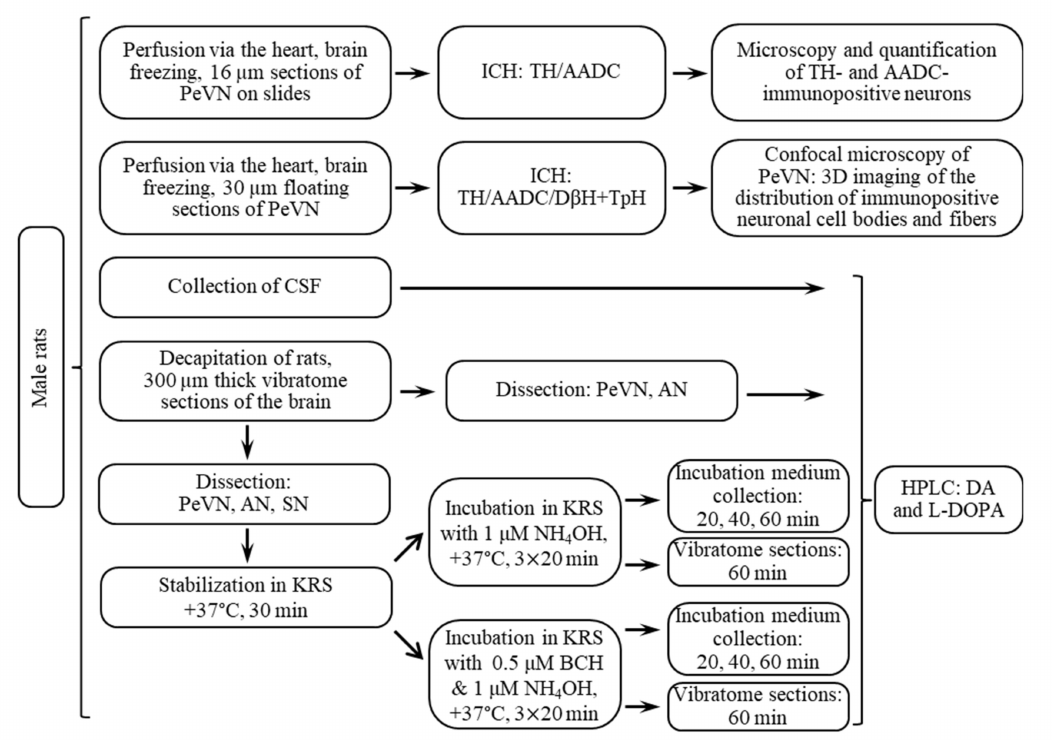
Figure 10. Scheme of experiments carried out on male Wistar rats at the age of 30 days. AADC, aromatic L-amino acid decarboxylase; AN, arcuate nucleus; BCH, 2-amino-2-norbornanecarboxylic acid; DA, dopamine; D β H, dopamine β hydroxylase; L-DOPA, L-3,4-dihydroxyphenylalanine; HPLC, high-performance liquid chromatography; ICH, immunocytochemistry; KRS, Krebs-Ringer solution; NH 4 OH, ammonium hydroxide; PeVN, periventricular nucleus; TpH, tryptophan hydroxylase; TH, tyrosine hydroxylase; SN, substantia